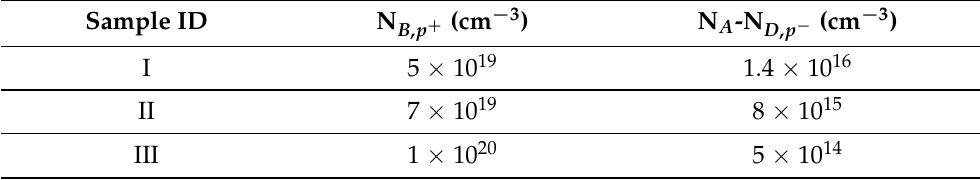
Table 1. Key parameters of the three samples referenced in this